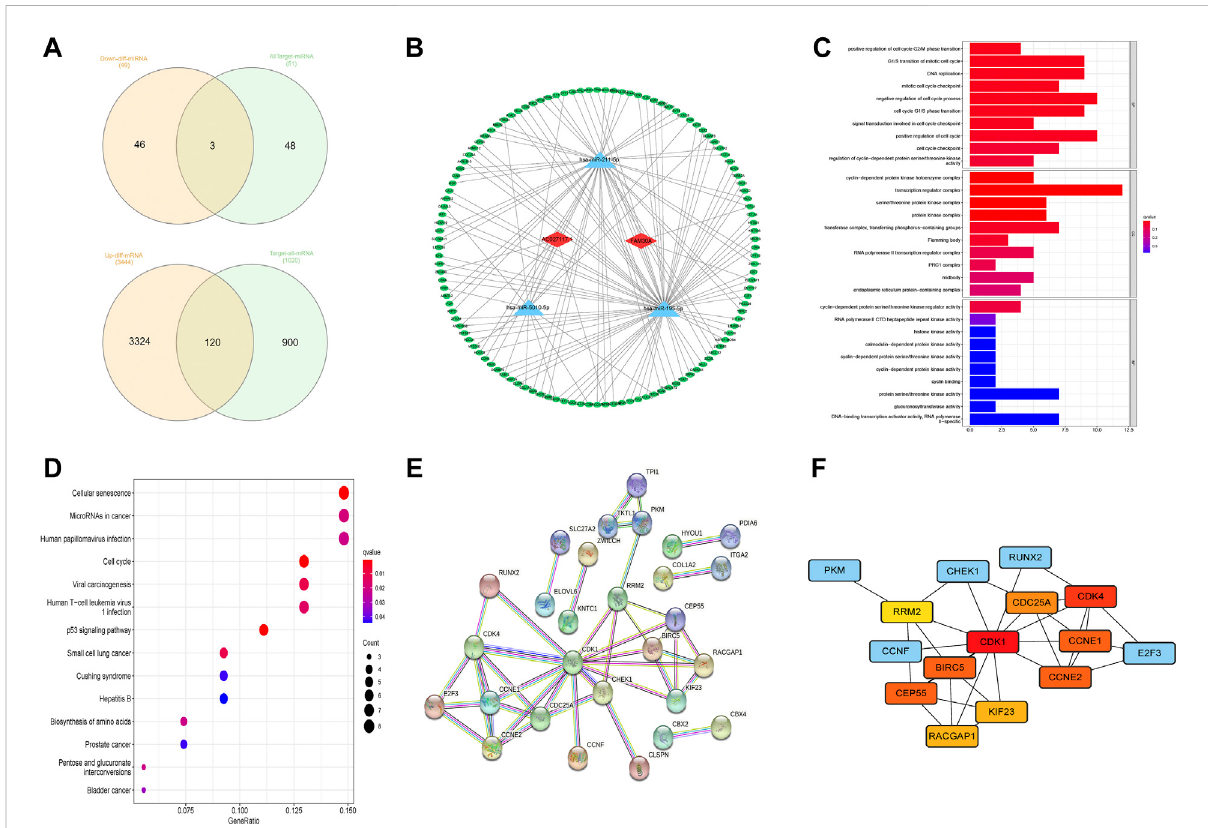
FIGURE 7 Construction of competing endogenous RNA network. (A) The predicted results of targeted miRNAs and targeted mRNAs obtained using StarBase and MiRTarBase. (B) The competing endogenous RNA (ceRNA) network between 2 lncRNAs, 3 miRNAs, and 120 downstream mRNAs. (C) Theenrichedtermsofdownstreamgenesingeneontology(GO)analysis. (D) TheenrichedtermsofdownstreamgenesintheKyotoEncyclopediaof Genes and Genomes (KEGG) analysis. (E,F) A protein – protein interaction (PPI) analysis of downstream genes and network of hub